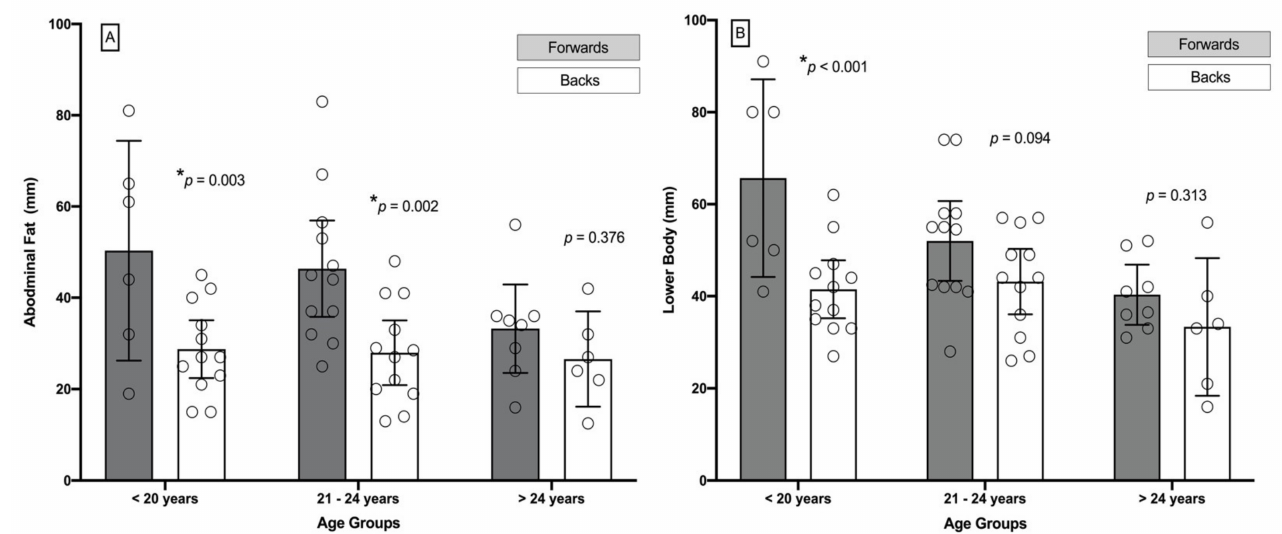
Figure 3. ( A ) Abdominal fat (mm) and ( B ) lower extremity fat (mm) in the three age groups regarding players position (i.e., forwards and backs) and age (i.e., <21 years, 21–25 years, and >25 years). Bars represent the mean and 95% of confident interval. * Asterisk represent significant differences ( p <